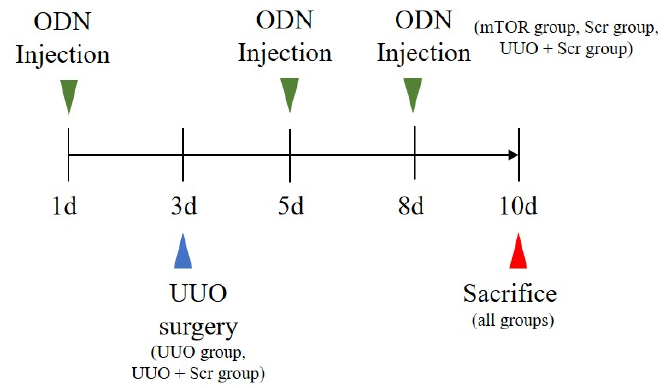
Figure 6. UUO surgery and synthetic mTOR ODN treatment scheme. Except for the mice in the NC and mTOR groups, all mice underwent UUO surgery on day 3. The mTOR group, UUO + mTOR group, and UUO + Scr group received tail vein injections of mTOR ODNs or Scr ODNs on days 1, 5, and 8. NC, normal control; UUO, unilateral ureteral obstruction; ODNs, oligonucleotides; Scr, scrambled; mTOR, mammalian target of